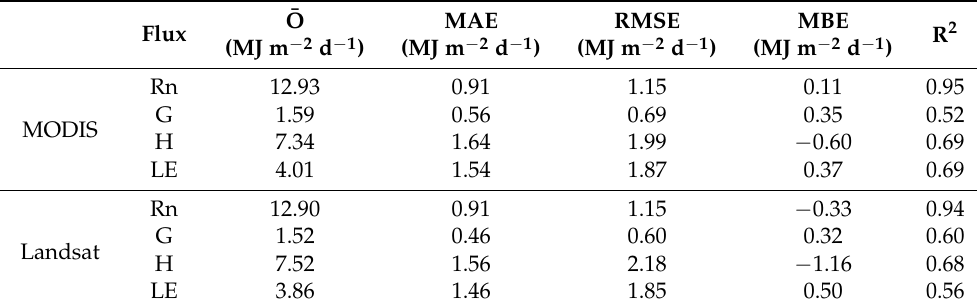
Table 1. Statistical metrics of daily energy fluxes generated by DisALEXI application with MODIS and Landsat images for